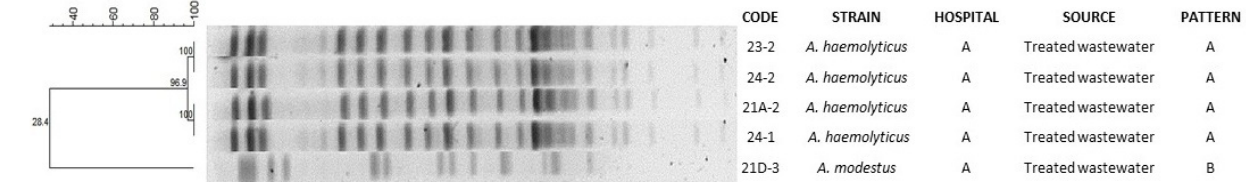
Figure 2. Dendrogram based on pulsed-field gel electrophoresis (PFGE) patterns after digestion with enzyme Apa I of Acinetobacter spp. isolates isolated from hospital wastewater.